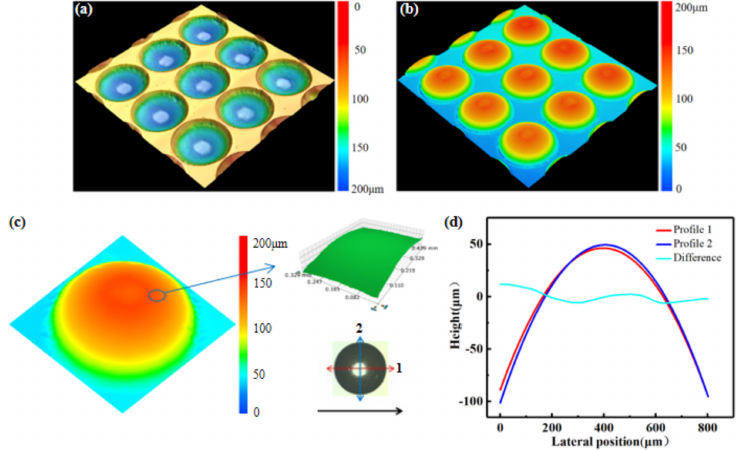
Figure 6. ( a ) 3 × 3 MLA characterization of the mold, ( b ) 3 × 3 MLA characterization of the sample, ( c ) the original measurement surface, and ( d ) the profile and error of the two radial cross-section